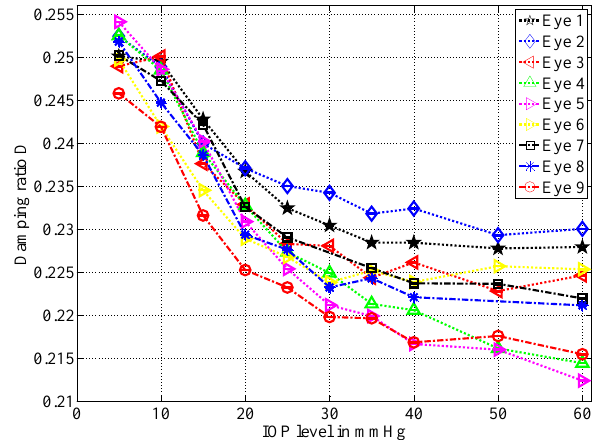
Figure 6. Damping ratio calculated according to formulae (4) and (5) for nine different porcine eyes. For all eyes the damping ratio decreases with the IOP level. The highest sensitivity is available in the range of 10 to 30mmHg. Two outlying data points have been excluded for the eyes 7 and 8 due to artifacts. Note that error bars are drawn but too small for